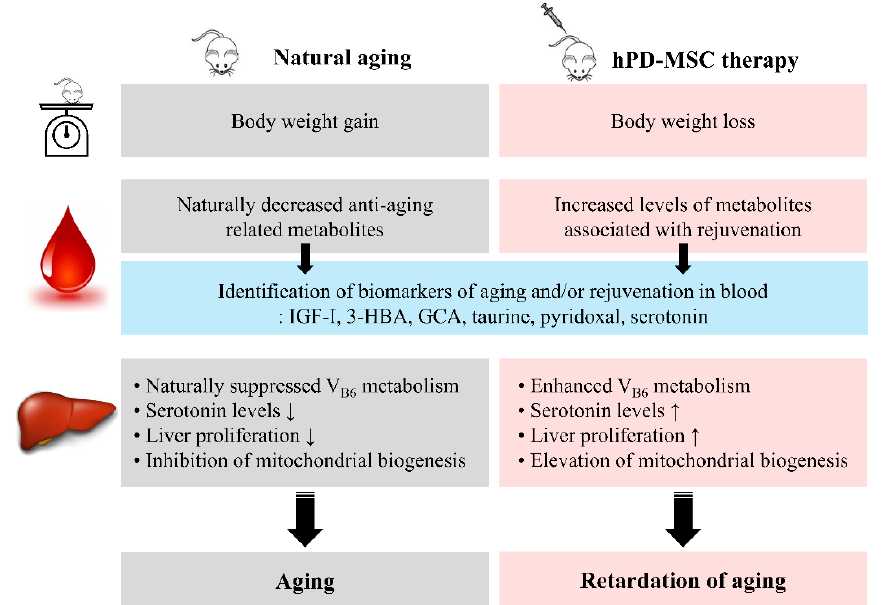
Figure 6. Schematic diagram of the experimental strategy used in the present study to investigate hPD-MSC therapy-induced rejuvenation in aged female rats. After hPD-MSC therapy, aged rats exhibited body weight reduction through metabolic regulation. Changes in factors in the blood related to metabolic alterations after hPD-MSC therapy should be considered candidate biomarker(s) of aging and/or rejuvenation. Furthermore, hPD-MSC therapy promoted serotonin production due to the activation of vitamin B6 metabolism. After hPD-MSC therapy, enhanced liver serotonin production may be essential for hepatocyte proliferation in relation to mitochondrial biogenesis. Clinical application of hPD-MSC therapy in elderly individuals in the future would be a solution for improving quality of life by slowing the aging process.